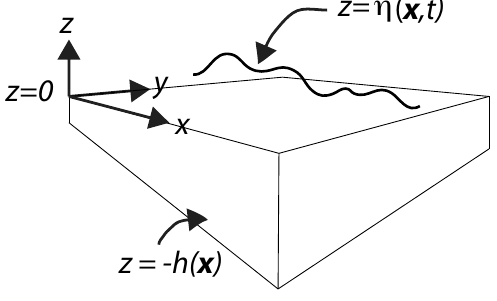
Figure 4. Schematic of the nearshore environment, z increases above the quiescent level of the sea z = 0 , x := ( x, y ) , and t is the time variable. The sea elevation z = η , includes a component of the free surface associated with the currents is z = η ( x , t ) and a component associated with waves. The bottom topography z = − h ( x ) is referenced to the quiescent sea level height, z = 0